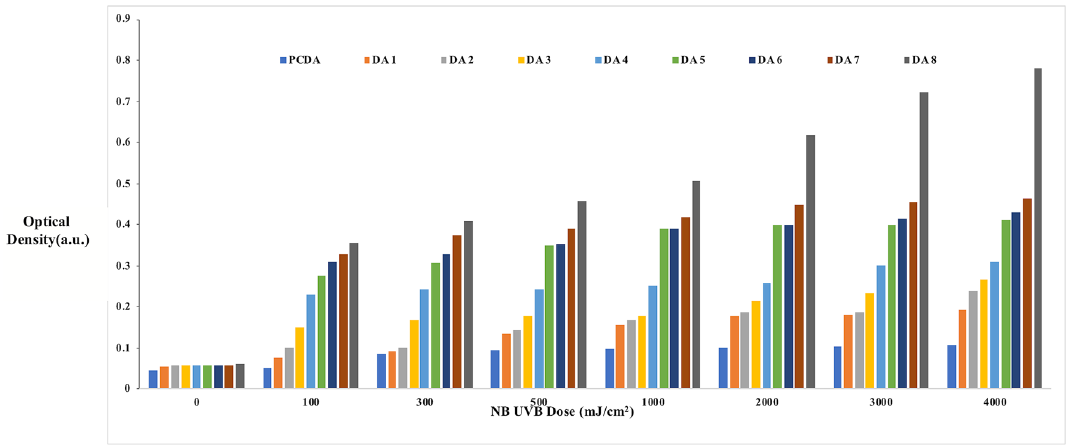
Figure 7. Digital image analysis of the prepared film